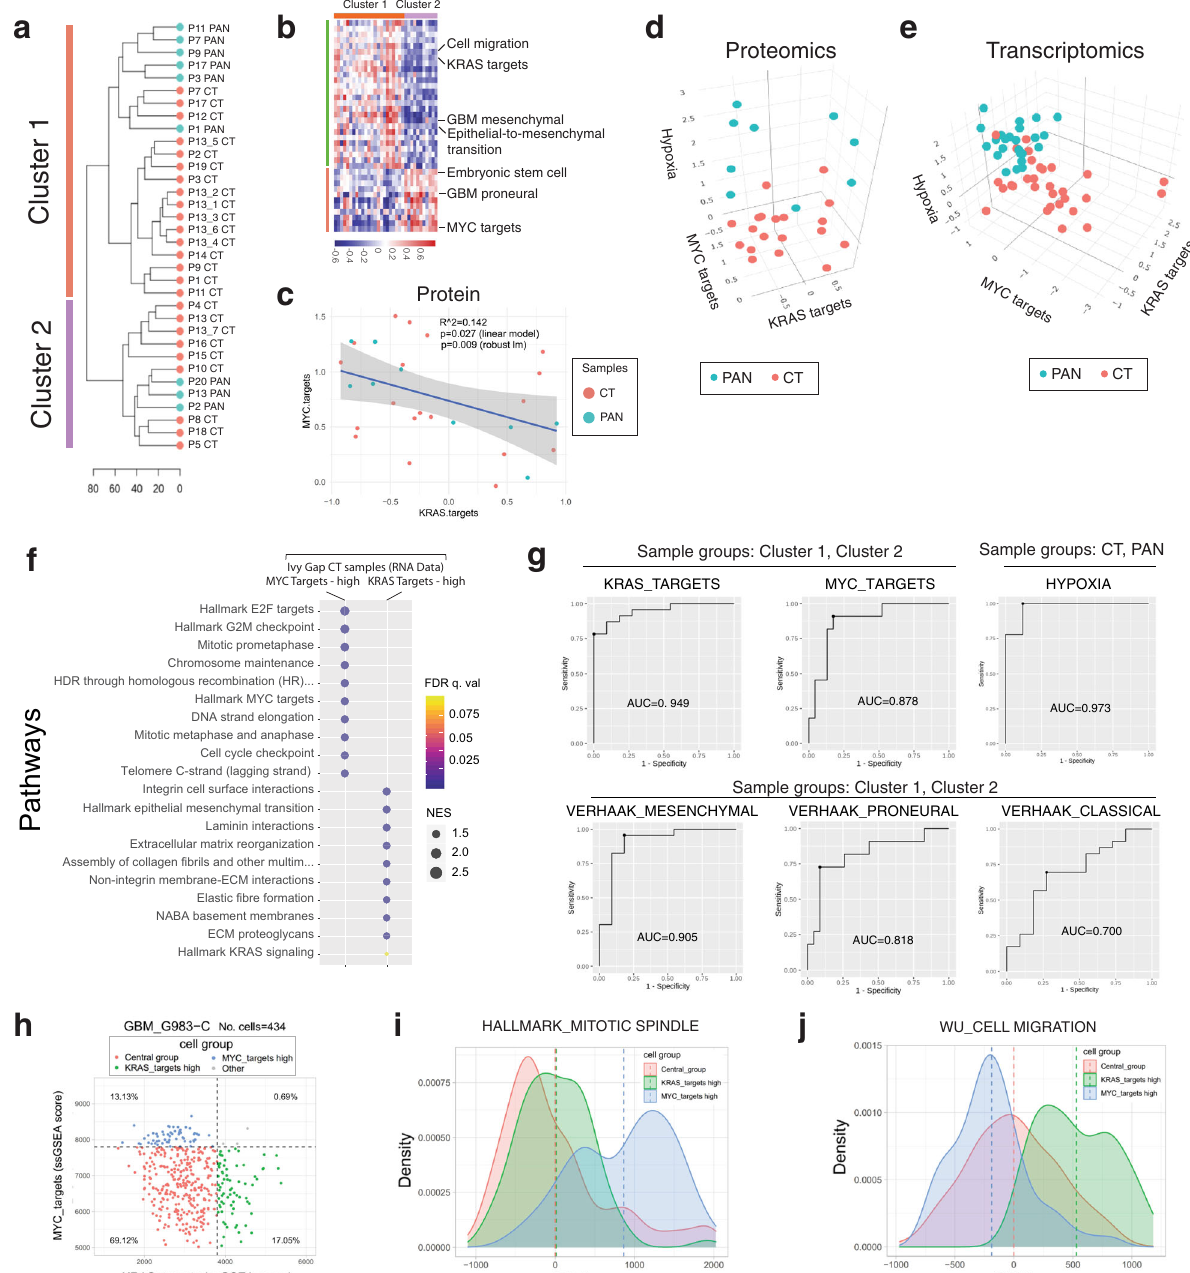
Fig. 4 Single-sample gene signature analysis of highly pure GBM tumour fractions reveal two biologically distinct clusters. a Two clusters of samples, independent of histomorphologic niches, are revealed by hierarchical clustering of samples using the ssGSEA scores from 64 selected gene signatures. Teal represents palisading cells around necrosis (PAN) samples while orange represents cellular tumor (CT) samples. b Functional drivers associated with each cluster using psSubPathways software package. c Inverse correlation between the KRAS targets and MYC targets signatures in the protein dataset generated in this study ( n = 34 samples); additional null hypothesis testing was performed by permuted linear model fi t analysis (lmPerm R package, p = 0.024). The 95% con fi dence interval is shown as grey areas. d 3D scatter plot of ssGSEA values of KRAS targets, MYC targets, and hypoxia gene signatures using proteomics (this study). e Transcriptomics (Ivy Gap) data from histomorphologically-de fi ned samples. f Functional pro fi ling by GSEA of Ivy Gap CT samples for the groups of samples labeled as MYC targets-high ( n = 9) vs KRAS targets-high ( n = 5) while presenting low activation of the hypoxia signature. g ROC analysis of clustering based on KRAS_targets, MYC_targets, or HYPOXIA gene signatures compared to that using Verhaak et al. mesenchymal, proneural and classical gene sets using cut-off optimization with the Youden method. h Distribution of KRAS_targets and MYC_targets signature enrichments in GBM at the single-cell level (Richards et al.) where ( i ) Mitotic spindle enrichment is quanti fi ed across the three detected populations. j Cell migration process enrichment across the three detected populations. Source data are provided as a Source Data fi